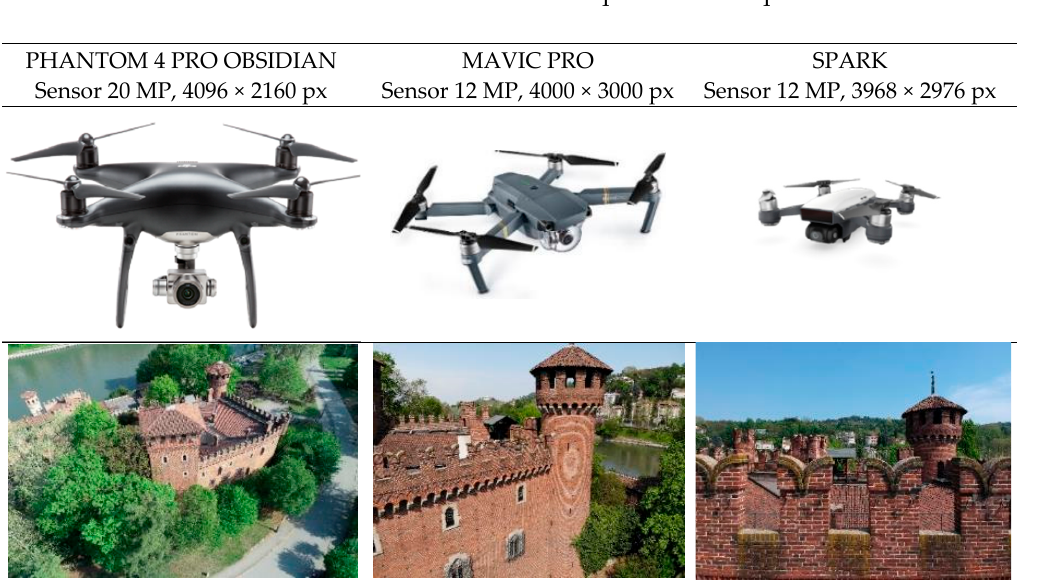
Figure 5. Different Unmanned Aerial Vehicle (UAV) platforms by DJI company and related sensors with captured images.